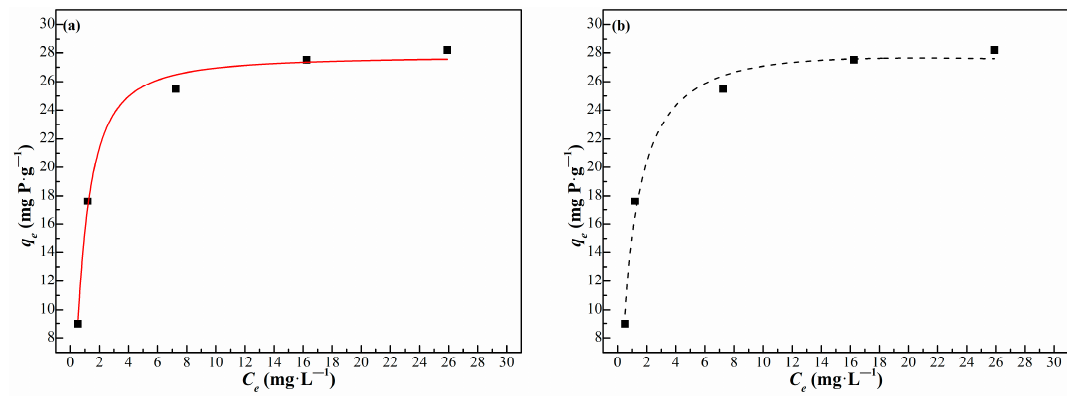
Figure 6. Langmuir ( a ) and Freundlich ( b ) models for the isotherm adsorption experiment. Table 2. Adsorption isotherm parameter fitting result of Langmuir and Freundlich model. Langmuir Model Freundlich Model Adsorbents La-chitosan magnetic spheres